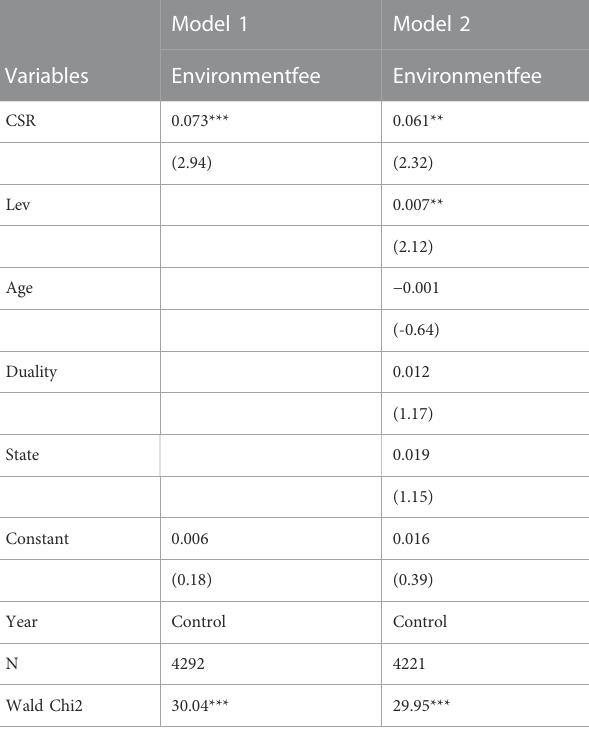
TABLE 4 Baseline regression.